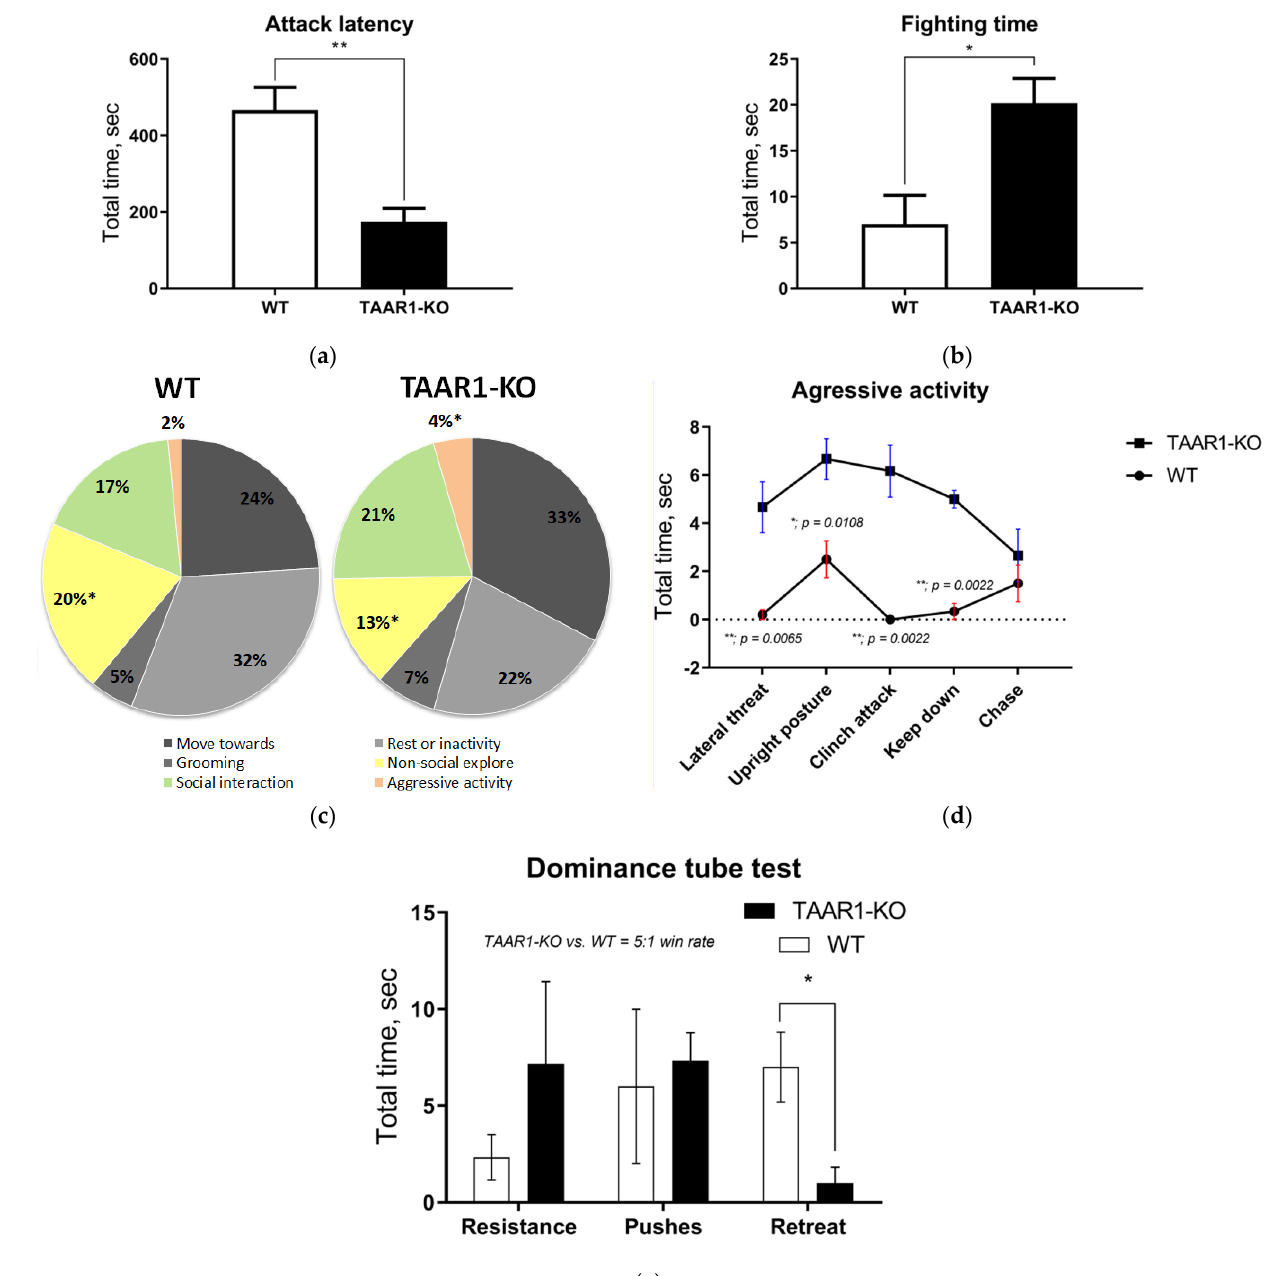
Figure 2. The resident–intruder ( a – d ) and the dominance tube ( e ) testing data show that TAAR1 knockout (KO) mice displayed more aggressive and dominant behavior vs. the wild type (WT) control mice. The TAAR1-KO group demonstrated significantly shorter attack latency (( a ); WT = 466 ± 59.67, vs. TAAR1-KO = 174 ± 35.53, p = 0.0087) and longer fighting time (( b ); WT = 7 ± 3.14, vs. TAAR1-KO = 20 ± 2.71, p = 0.03), as well as less non-social exploration (( c ); WT = 92 ± 5.27, vs. TAAR1-KO = 58 ± 8.81, p = 0.015), increased aggressive activity ( d ) and fewer retreats in the dominance tube test (( e ), WT = 7 ± 1.8, vs. TAAR1-KO = 1 ± 0.82, p = 0.035). Data are presented as mean ± SEM (n = 6). * p < 0.05, ** p < 0.05 vs. control, Mann–Whitney U-test. Analyzing mouse self-grooming behavior and its microstructure, we found more organized and less chaotic microstructure in the TAAR1-KO mice, including fewer in- correct transitions (%), grooming episodes, rostral and caudal bouts, as well as fewer